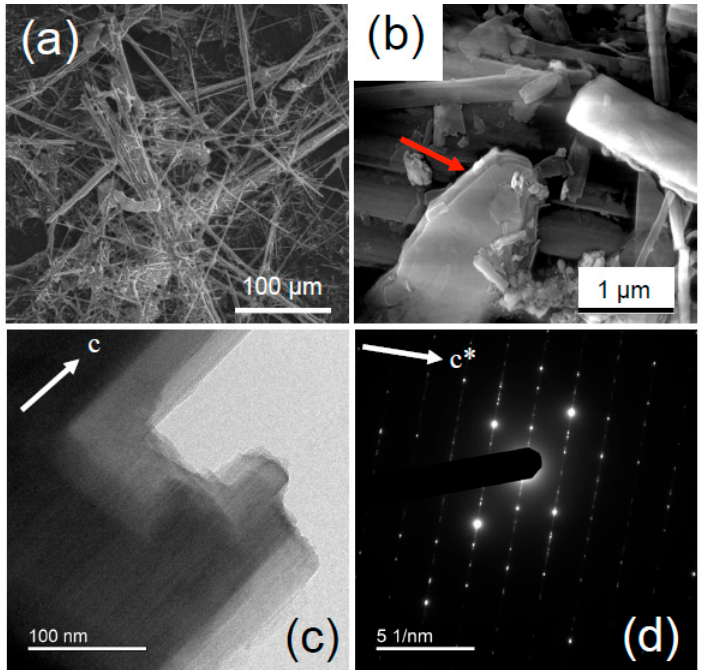
Figure 2. UICC standard anthophyllite Finnish NB #4173-111-5 sample (Table 1). Representative FEG-ESEM images at relatively low ( a ) and high ( b ) magnification, where a platy talc particle (red arrow) is visible. ( c ) High-resolution TEM image highlighting edge features of the fiber viewed along the c axis, and ( d ) SAED pattern parallel to the c * axis.